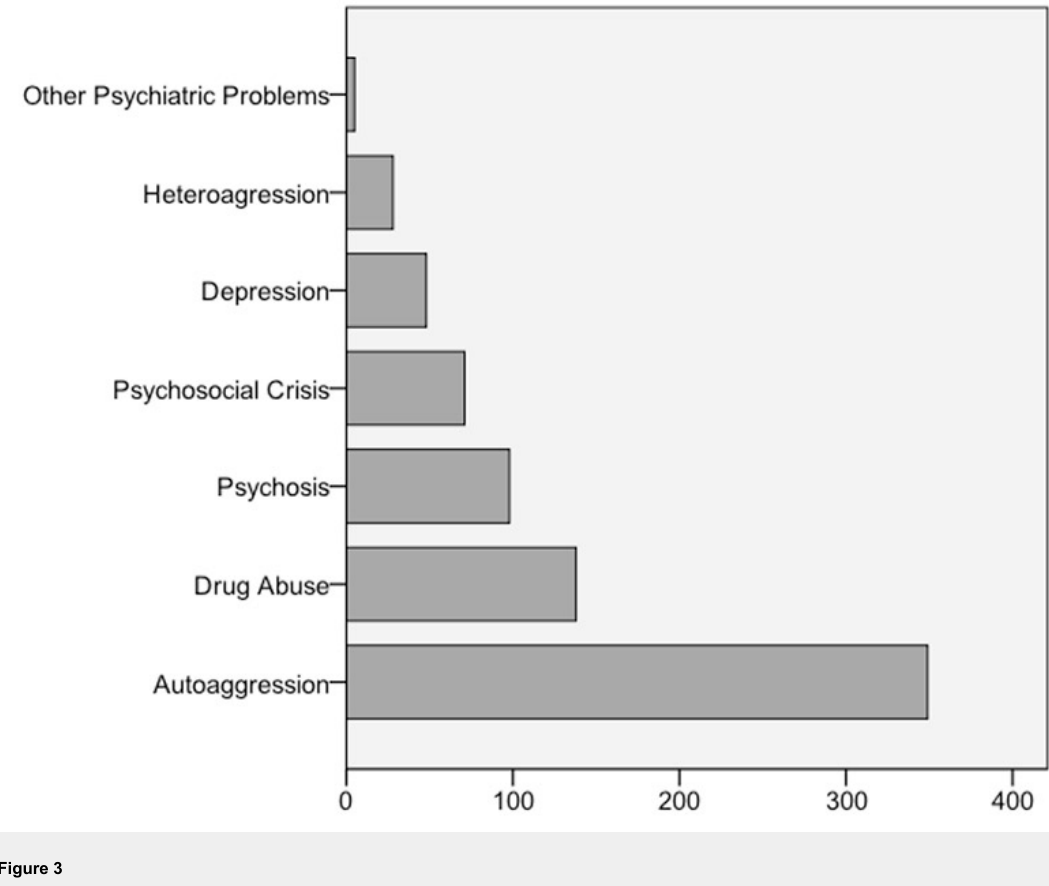
Figure 3 ■Summary of admissions for psychiatric diseases (number of admissions per